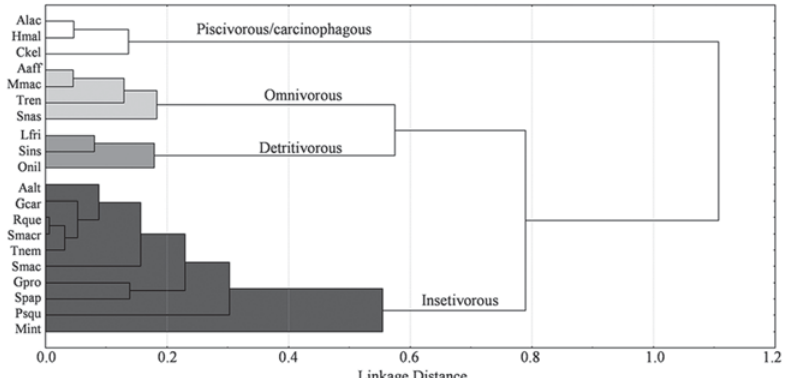
Fig. 3. Cluster analysis of diet similarity among species, showing the trophic guilds of the fish community from the Nova Avanhandava Reservoir.